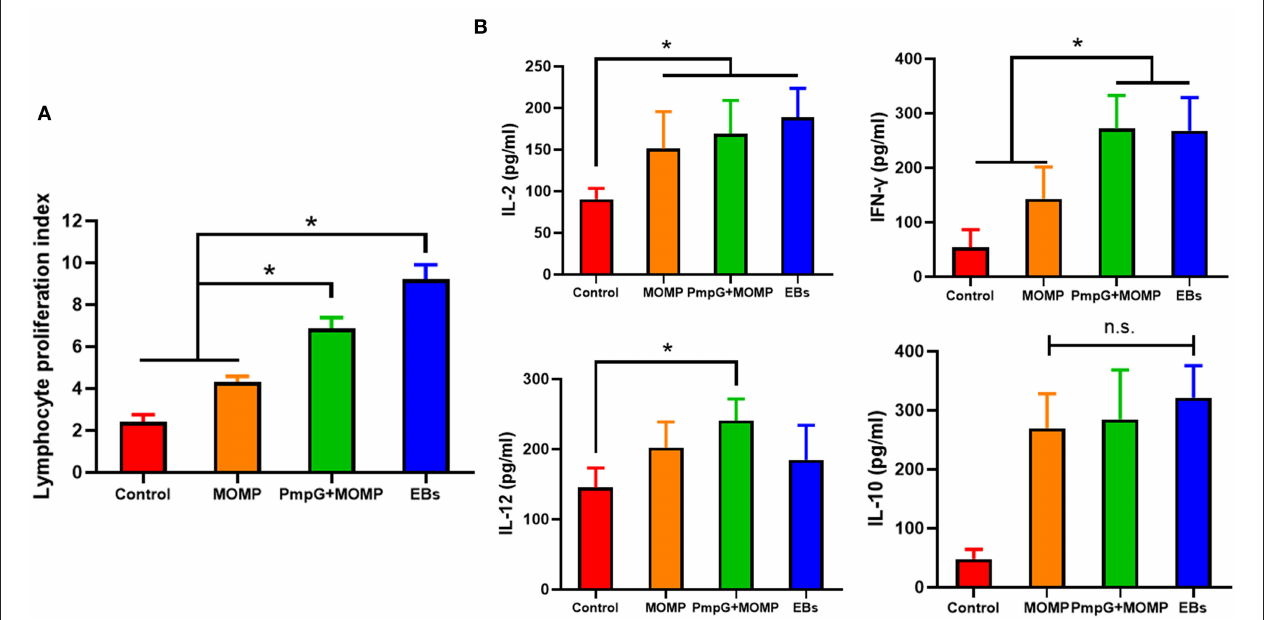
FIGURE 7 | Lymphocyte proliferation and cytokines secretions post inoculation into breeder ducks. (A) After booster immunization, the PmpGs + MOMP group and the inactivated EBs group upregulated significantly lymphocyte proliferations index compared with the commercial MOMP vaccine ( p < 0.05). (B) IFN- γ expressions were increased significantly in the PmpGs + MOMP group compared with the commercial MOMP group ( p < 0.05), IL-2 production was upregulated among the PmpGs + MOMP group, the inactivated EBs group, and the commercial MOMP group in comparison with the control group ( p < 0.05). IL-10 secretions showed no significant difference among all groups. The differences were analyzed by ANOVA (* p < 0.05, n.s., no statistical